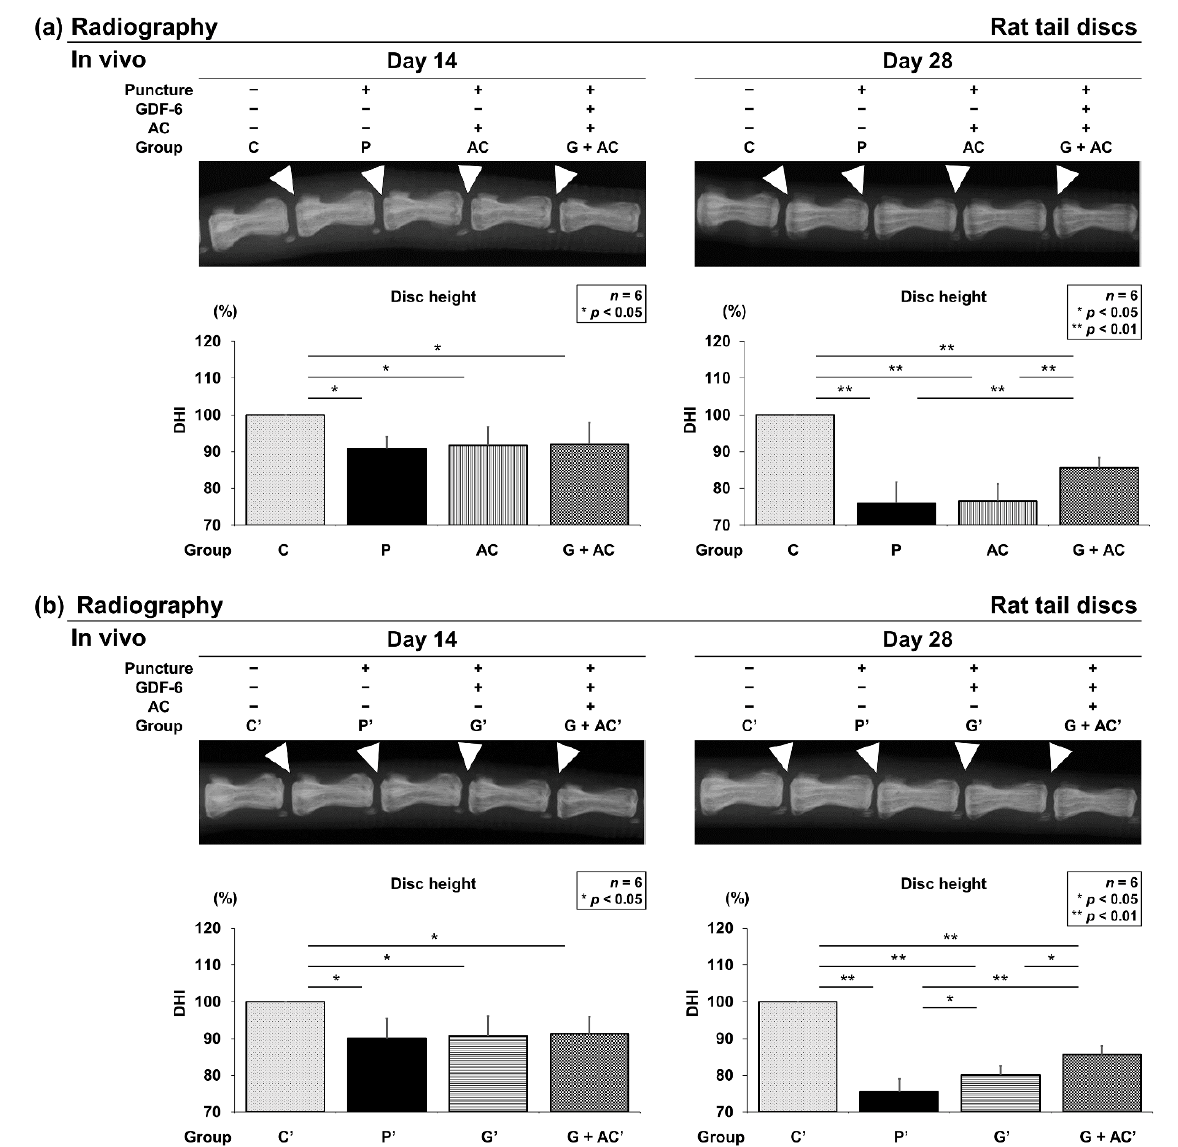
Figure 5. Effects of co-administration of growth differentiation factor-6 (GDF-6) and atelocollagen (AC) on radiographic disc height in a rat tail intervertebral disc annular puncture model. A 20-G needle was used to puncture the rat caudal disc at a depth of 5 mm from the skin to the center of nucleus pulposus. The needle was rotated 360 ◦ and held in that position for 30 s before extraction to establish an intervertebral disc degeneration model. Following the initial puncture, ( a ) either vehicle (phosphate-buffered saline [PBS]; 2 µ L per disc, group P), atelocollagen (AC; 2- µ L AC per disc, group AC), or GDF-6 (20 µ g in 2- µ L AC gel per disc, group G + AC) or ( b ) vehicle (PBS; 2 µ L per disc, group P (cid:48) ), GDF-6 (20 µ g in 2- µ L PBS per disc, group G (cid:48) ), or GDF-6 (20 µ g in 2- µ L AC gel per disc, group G + AC (cid:48) ) was randomly injected. Lateral radiographs of the rat tail were obtained on days 14 and 28 postoperatively, and the disc height index (DHI) was calculated by measuring, averaging, and normalizing the disc height compared to the adjacent vertebral body heights in the anterior, middle, and posterior regions. We designated the control without puncture as 100% (groups C and C (cid:48) ), and compared the four groups (C, P, A, G + AC) and (C (cid:48) , P (cid:48) , G (cid:48) , G + AC (cid:48) ). Data are the mean ± standard deviation ( n = 6). One-way analysis of variance with the Tukey–Kramer post-hoc test was used. Significant differences are set as * p < 0.050 and ** p <